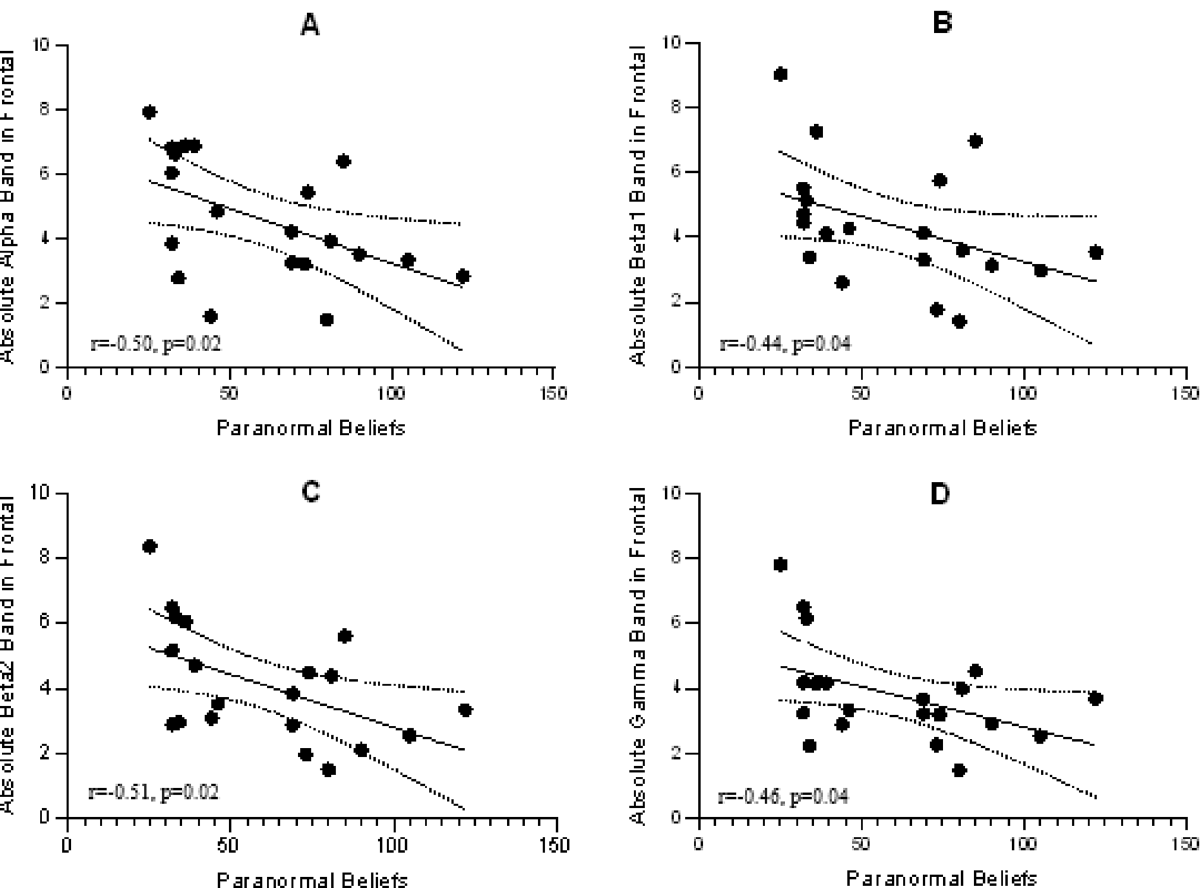
Figure 6. The figure of correlation between EEG power bands and paranormal beliefs score in frontal lobe. The X-axis represents the scores of paranormal beliefs and the Y-axis represents the absolute power in the ( A ) alpha, ( B ) beta1, ( C ) beta2, and ( D ) gamma band activities in frontal lobe. Line dots are presented %95 confidence band of the best